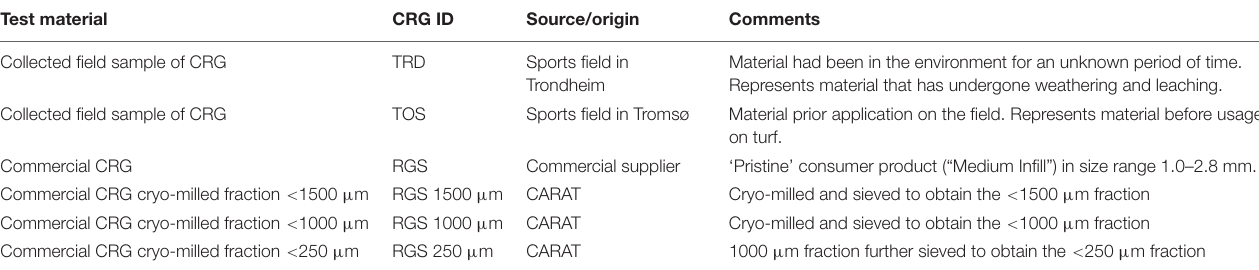
TABLE 1 | Overview of tire-derived crumb rubber granulate (CRG) reference materials used in the